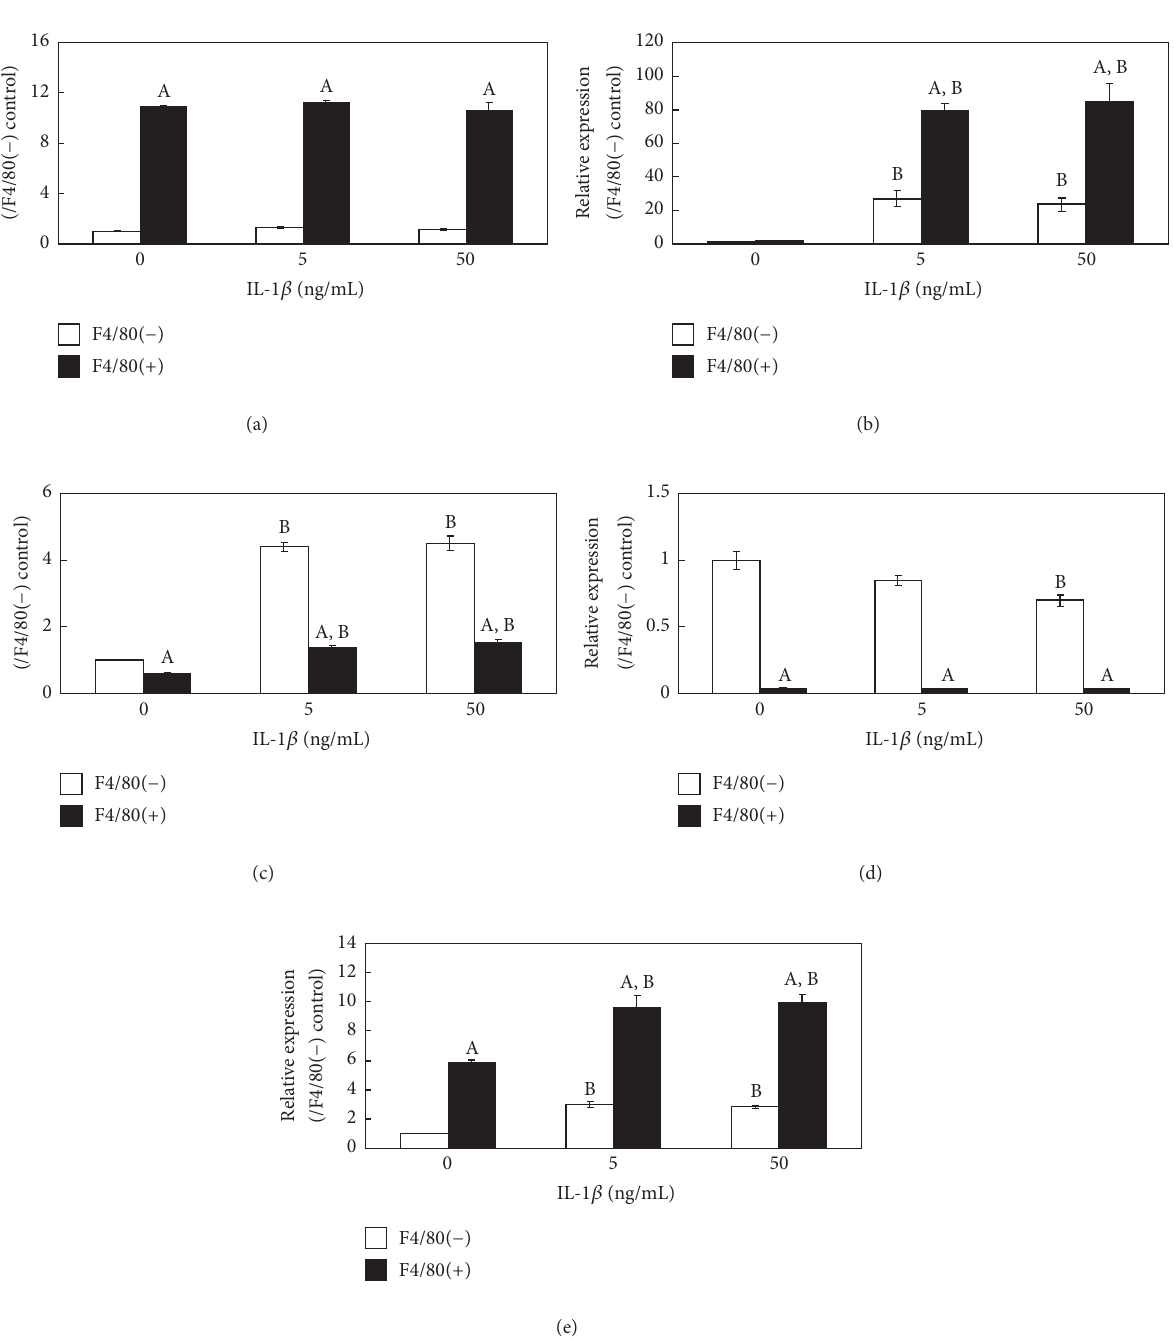
Figure 4: Effects of interleukin- (IL-) 1 𝛽 on IL-1 𝛽 , adrenomedullin (AM), and receptor activity-modifying protein 2 (RAMP2), and RAMP3 gene expression in cultured primary synovial fibroblasts and macrophages. The effects of IL-1 𝛽 on F4/80 (a), IL-1 𝛽 (b), AM (c), RAMP2 (d) and RAMP3 (e) gene expression in cultured primary synovial fibroblasts (F4/80-negative fraction) and macrophages (F4/80-positive fraction) were examined by real-time PCR. A 𝑃 < 0.05 compared with F4/80-negative fraction. B 𝑃 < 0.05 compared with fraction matched-untreated